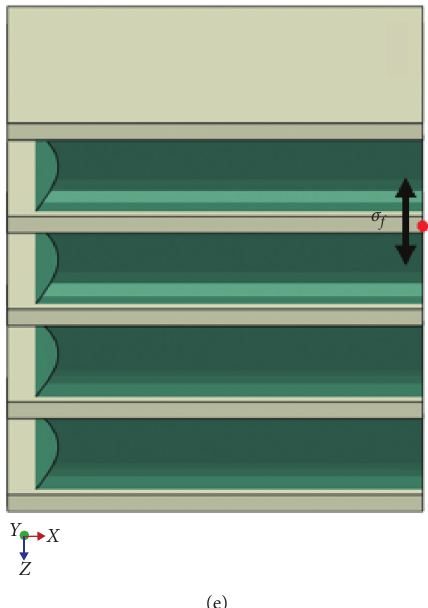
Figure 9: The profile and the orientation of the effective stress of the sandwich mount. (a) The effective stress profile. (b) The zoomed critical area of the sandwich mount. (c) The effective stress direction at the hot spot of the sandwich mount in the YOZ plane (60.5 ° from Z). (d) The effective stress direction at the hot spot of the sandwich mount in the XOY plane (90 ° from X). (e) The effective stress direction at the hot spot of the sandwich mount in the XOZ plane (90 ° from